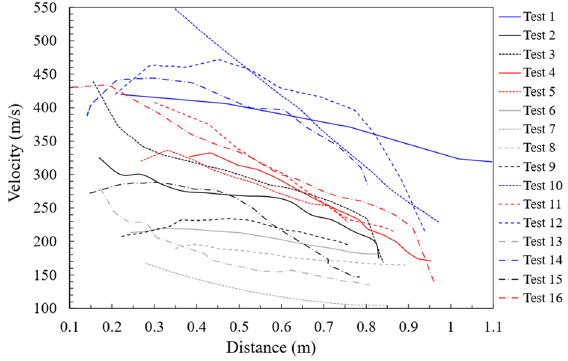
Figure 9. Experimentally measured water front velocity versus distance.